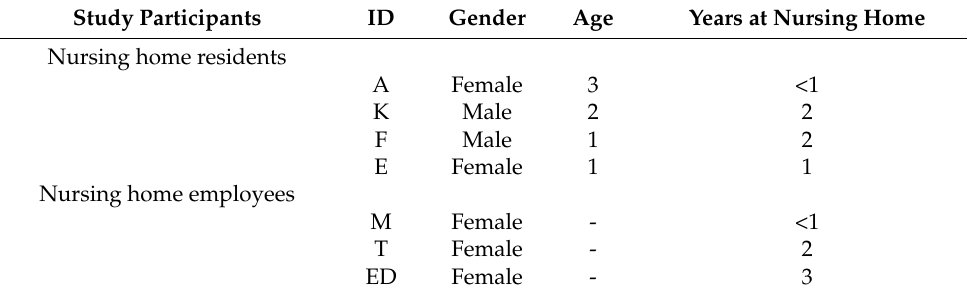
Table 1. Characteristics of the study